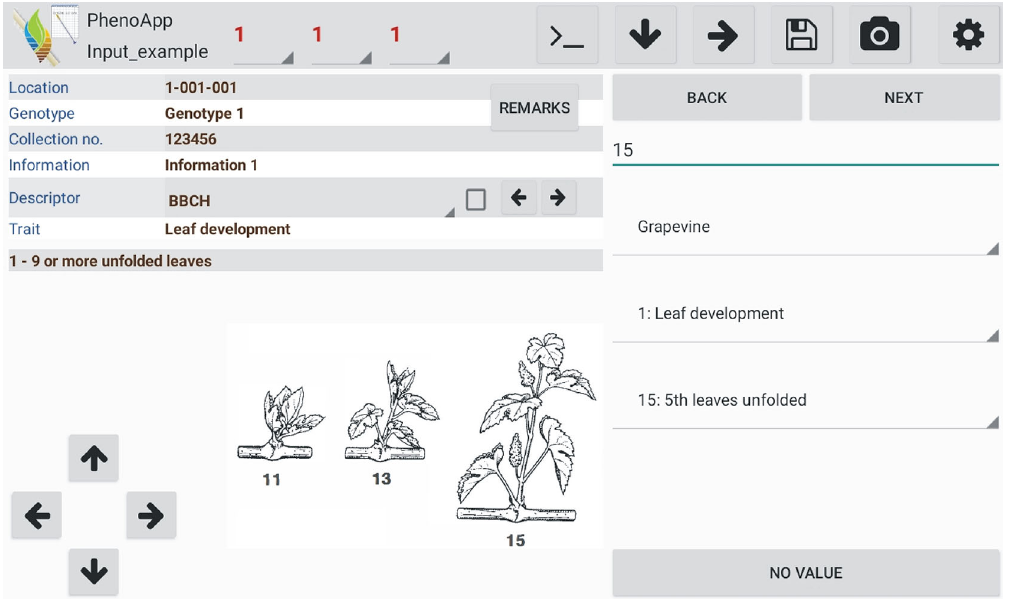
Figure 1. General app view with a data-recording example for a BBCH (Biologische Bundesanstalt für Land- und Forstwirtschaft, Bundessortenamt und CHemische Industrie) growth stage of